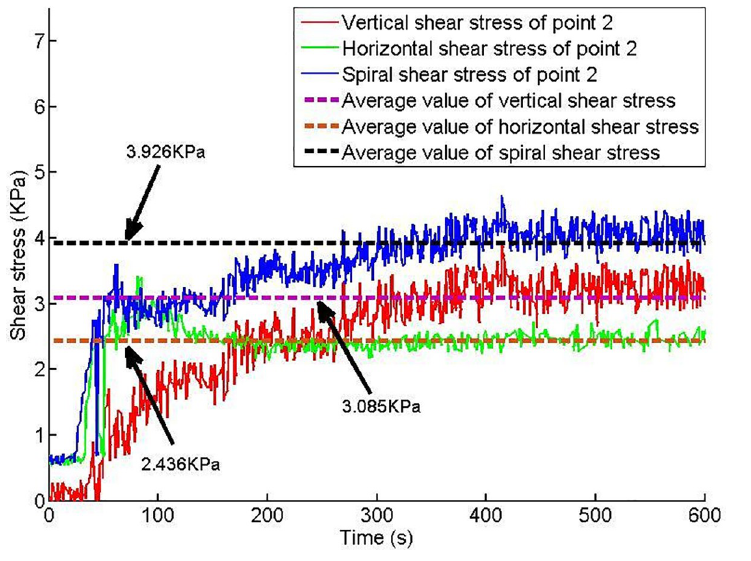
Fig 14. Shear stress of testing point